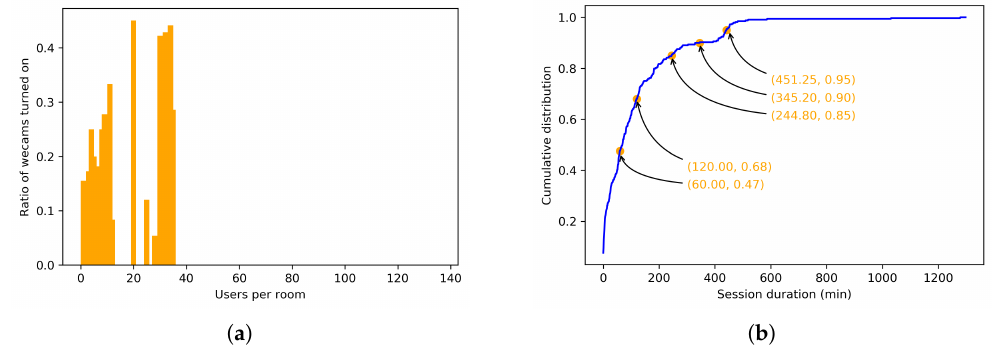
Figure 8. Measured usage statistics. ( a ) Number of shared webcams; ( b ) Duration of VC